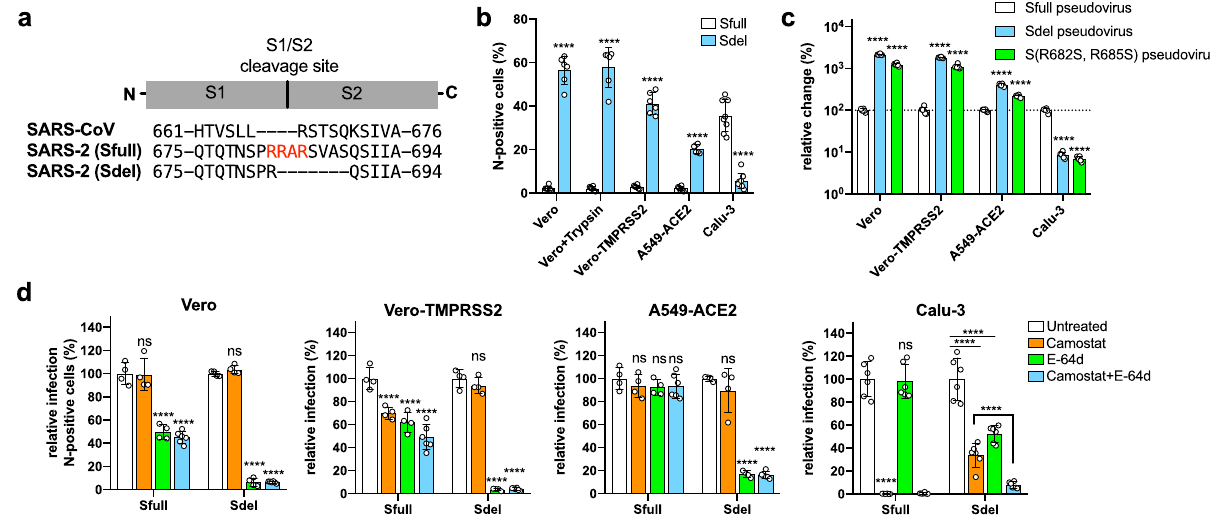
Fig. 1 The deletion at the S1/S2 boundary of spike protein propels the virus to enter cells through the endosomal pathway. a Sequence alignment of spike protein encompassing the cleavage site between S1 and S2 subunits. The spike proteins of SARS-CoV-2 without (Sfull strain) and with (Sdel strain) deletion were used to compare with that of SARS-CoV. The insertion of multi-basic amino acids in spike protein of SARS-CoV-2 was shown in red. b Comparison of the replication property between Sfull and Sdel strains in different cell lines. The percentage of nucleocapsid (N) protein-positive cells was analyzed by imaging-based analysis following virus infection (two or more experiments; n = 6 except for Calu-3 in which n = 8; one-way ANOVA with Dunnett ’ s test; mean ± s.d.). c Evaluation of entry ef fi ciency in different cell lines infected with pseudoviruses bearing spike protein Sfull, Sdel, or S mutant (R682S, R685S). Data are normalized to the Sfull of individual experiments (two experiments; n = 6; one-way ANOVA with Dunnett ’ s test; mean ± s.d.). d Effect of TMPRSS2 serine protease inhibitor Camostat and cysteine protease inhibitor E-64d on Sfull or Sdel infection in different cell lines (two experiments; n = 4 or 6; one-way ANOVA with Dunnett ’ s test; mean ± s.d.). Data shown were normalized to the untreated group of individual experiments. **** P < 0.0001; n.s. not signi fi